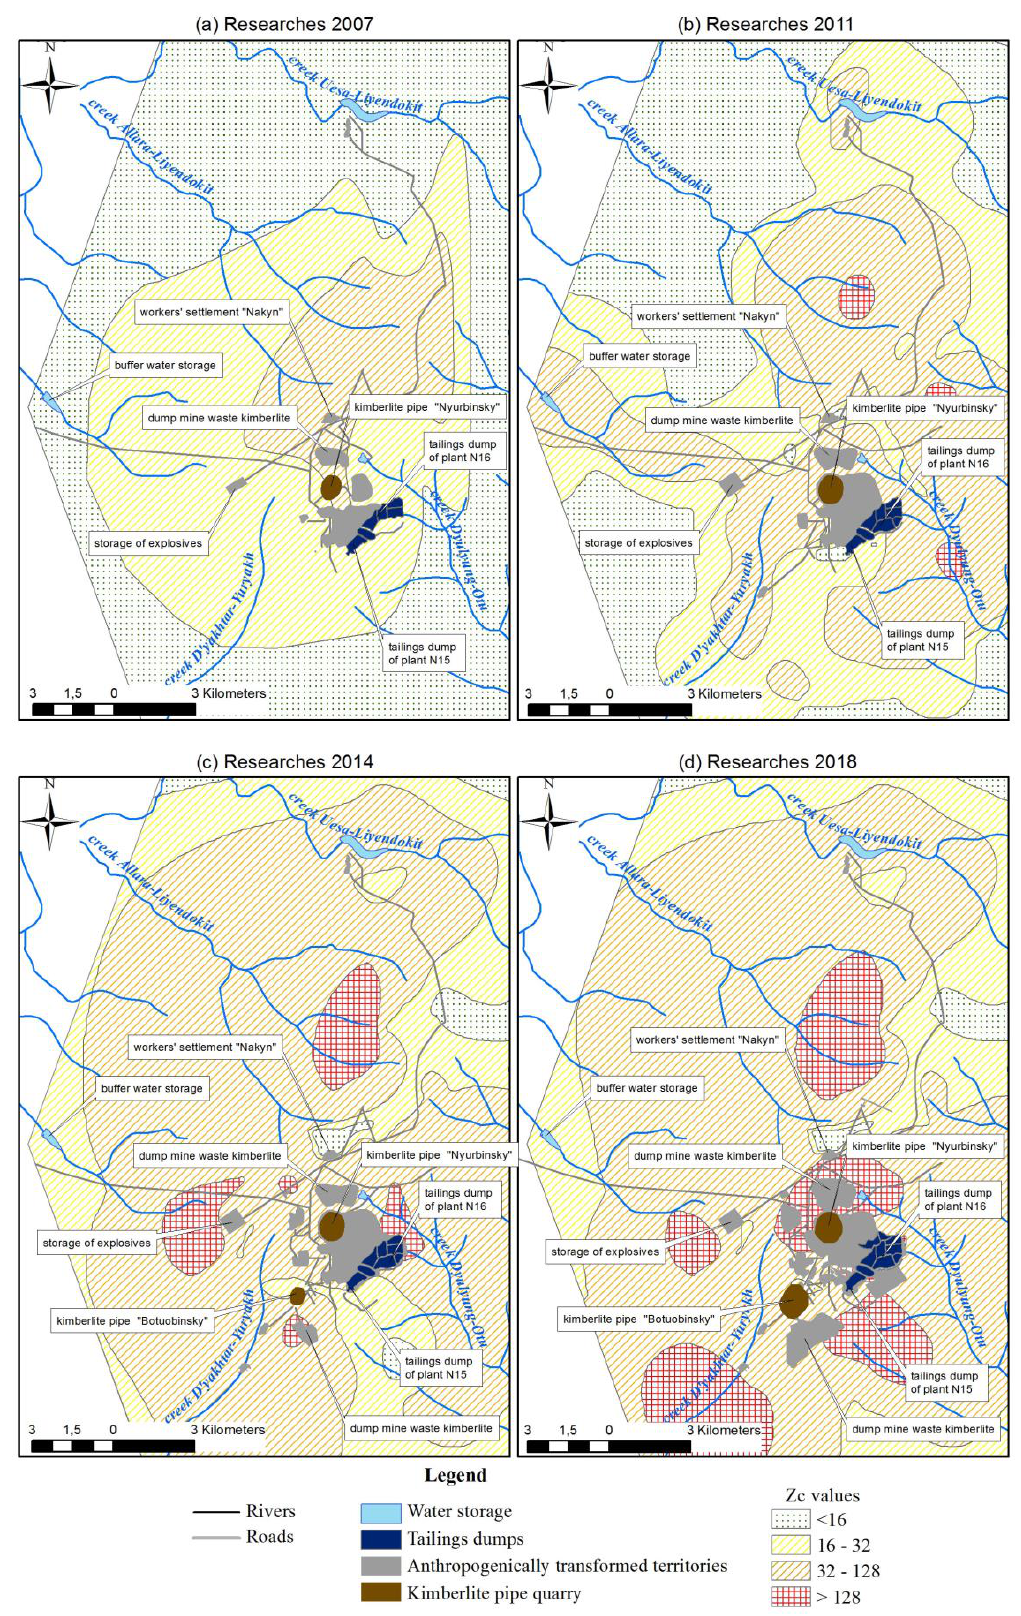
Figure 7. Dynamics of the index of total soil contamination (Z c ), 2007 −2 018 : ( a ) 2007; ( b ) 2011; ( c ) 2014; ( d ) 2018.